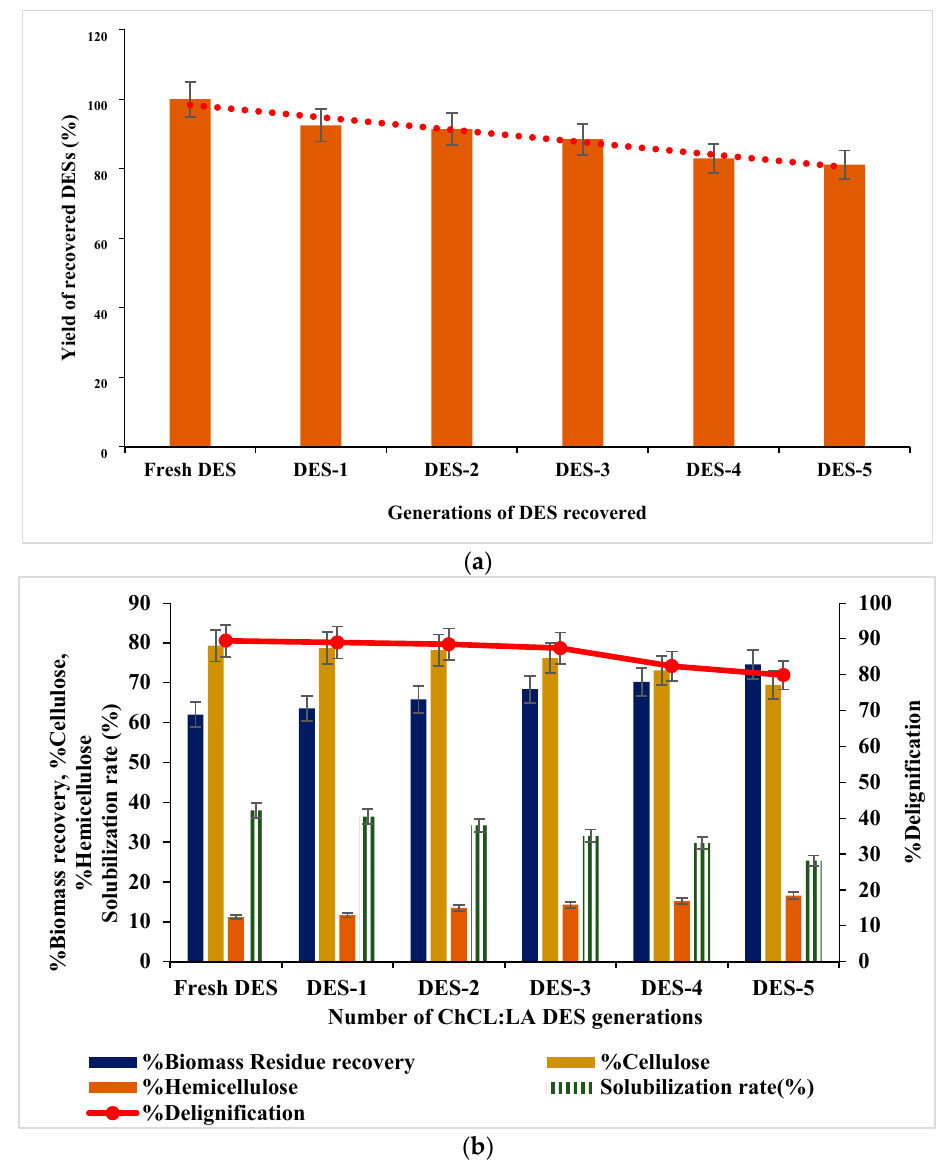
Figure 5. ( a ) Recovery yield (%) of ChCl: LA DES up to five pretreatment cycles. ( b ) Characterization of Atriplex crassifolia after pretreating the substrate from regenerated ChCl: LA DESs.